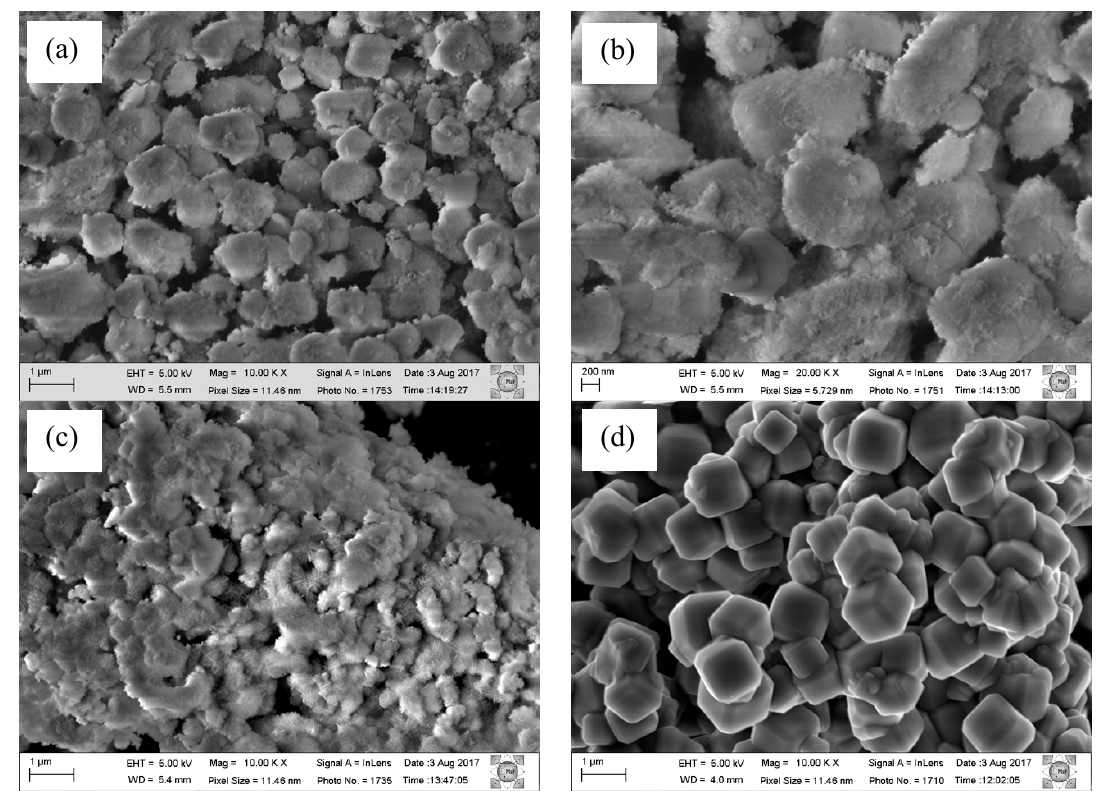
Figure 3. Micrograph of the composite ZAHD(a and b) material compared to zeolite A (c) and LDH (d).